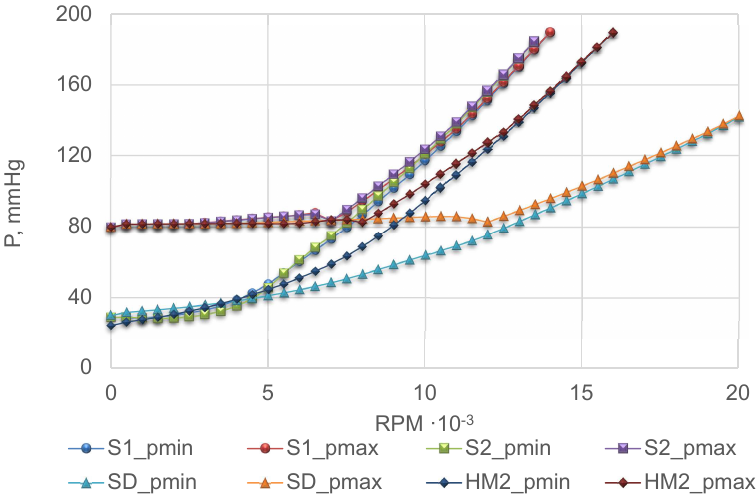
Figure 6. The systolic and diastolic pressures in the aortic